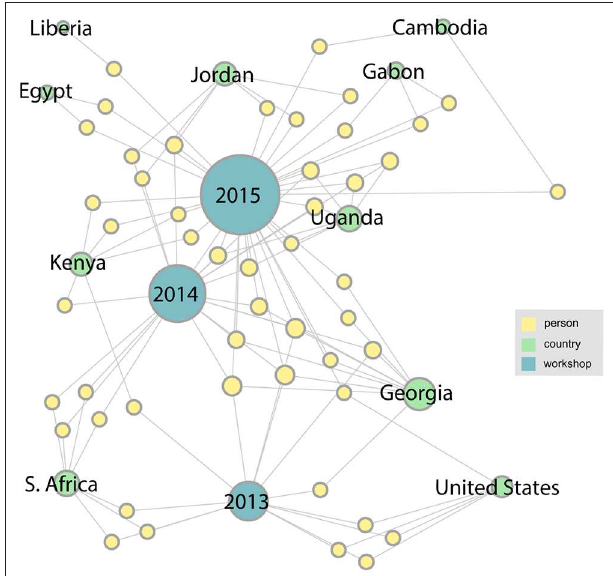
FIGURE 4 | By 2015, with the addition of two more workshops in the series, the network becomes more complex, with several new participating countries